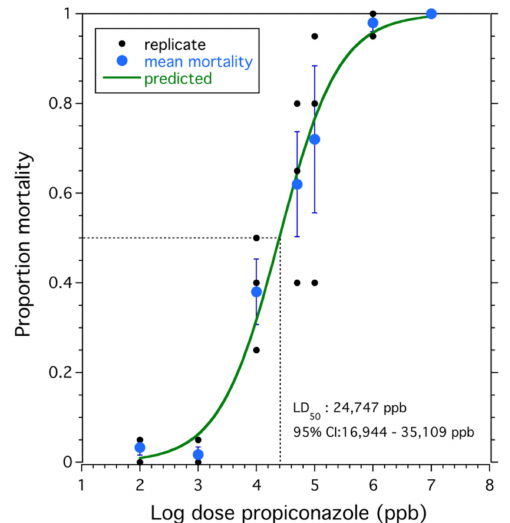
Figure 5. The proportion mortality after 24 h contact exposure to logarithm transformed doses of propiconazole (ppb). The blue symbols with standard error bars are the estimates of mean proportion mortality at each dose and the smaller black symbols are the individual replicate estimates of propor- tion mortality ( n = 3). The green line is the estimated logistic regression predictive response